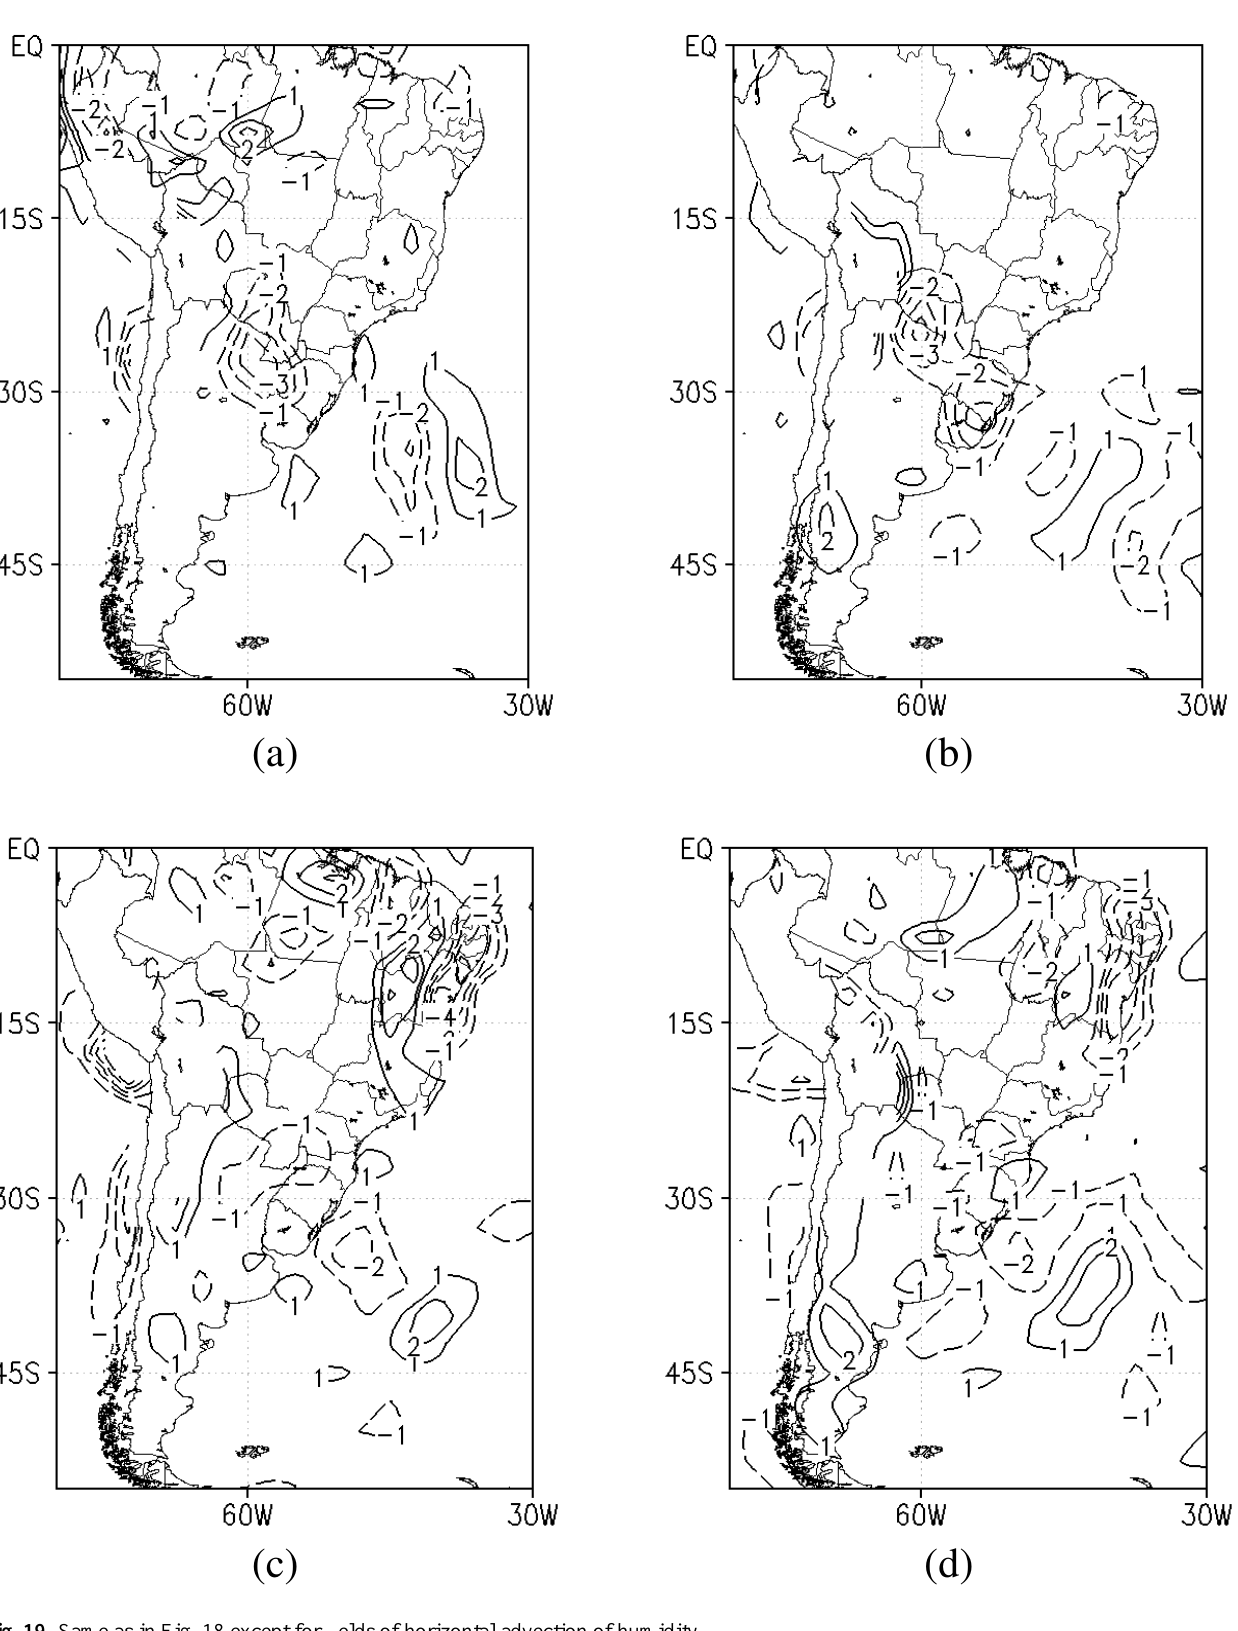
Fig. 19. Same as in Fig. 18 except for fields of horizontal advection of humidity. Fig. 19 – Same as in Fig. 18 except for fields of horizontal advection of humidity.